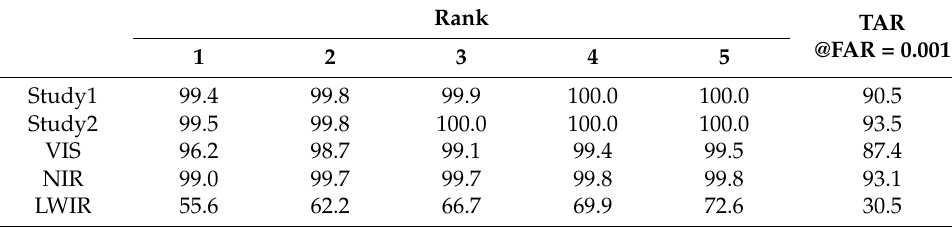
Table 9. Results (in %) obtained in the face recognition task, in the TUFTS-Pose database.